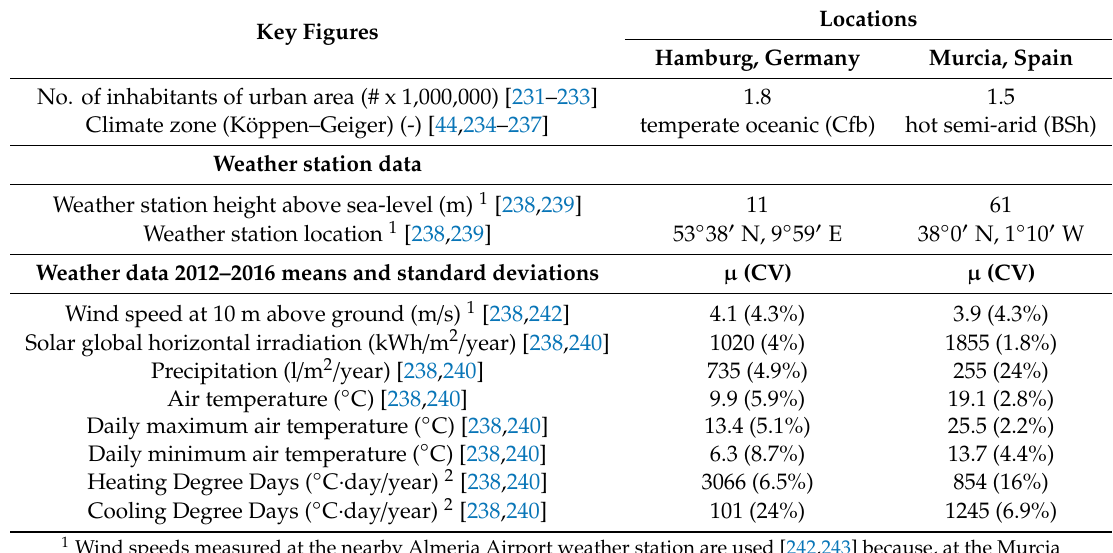
Table A1. Key figures, characterizing the climate of the two locations, Hamburg and